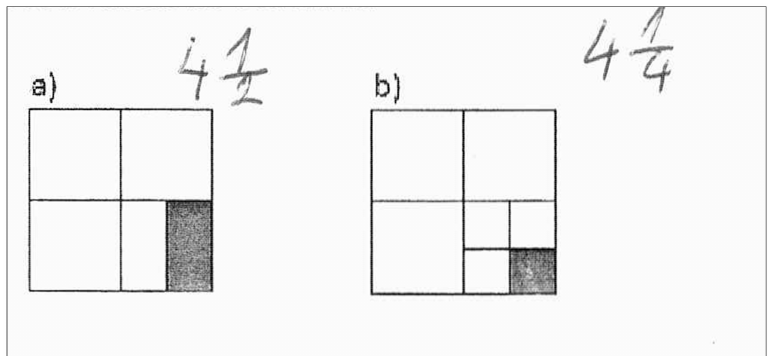
Figure 10. Incorrect solution 4.